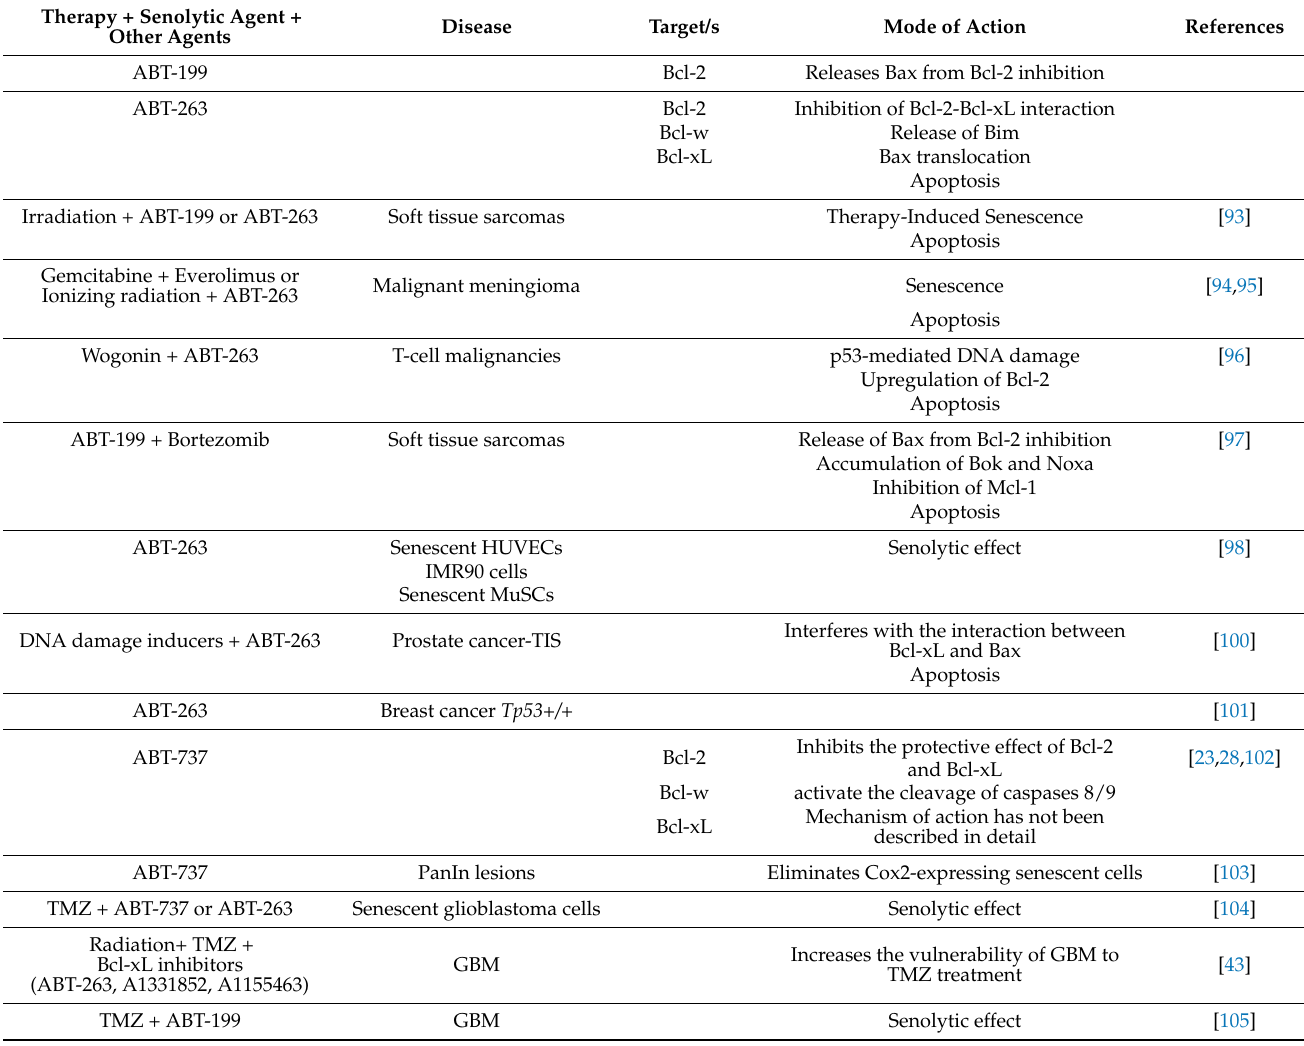
Table 1. Senolytic agents targeting Bcl-2 family proteins alone or in combinatorial therapy and their modes of action in cancer